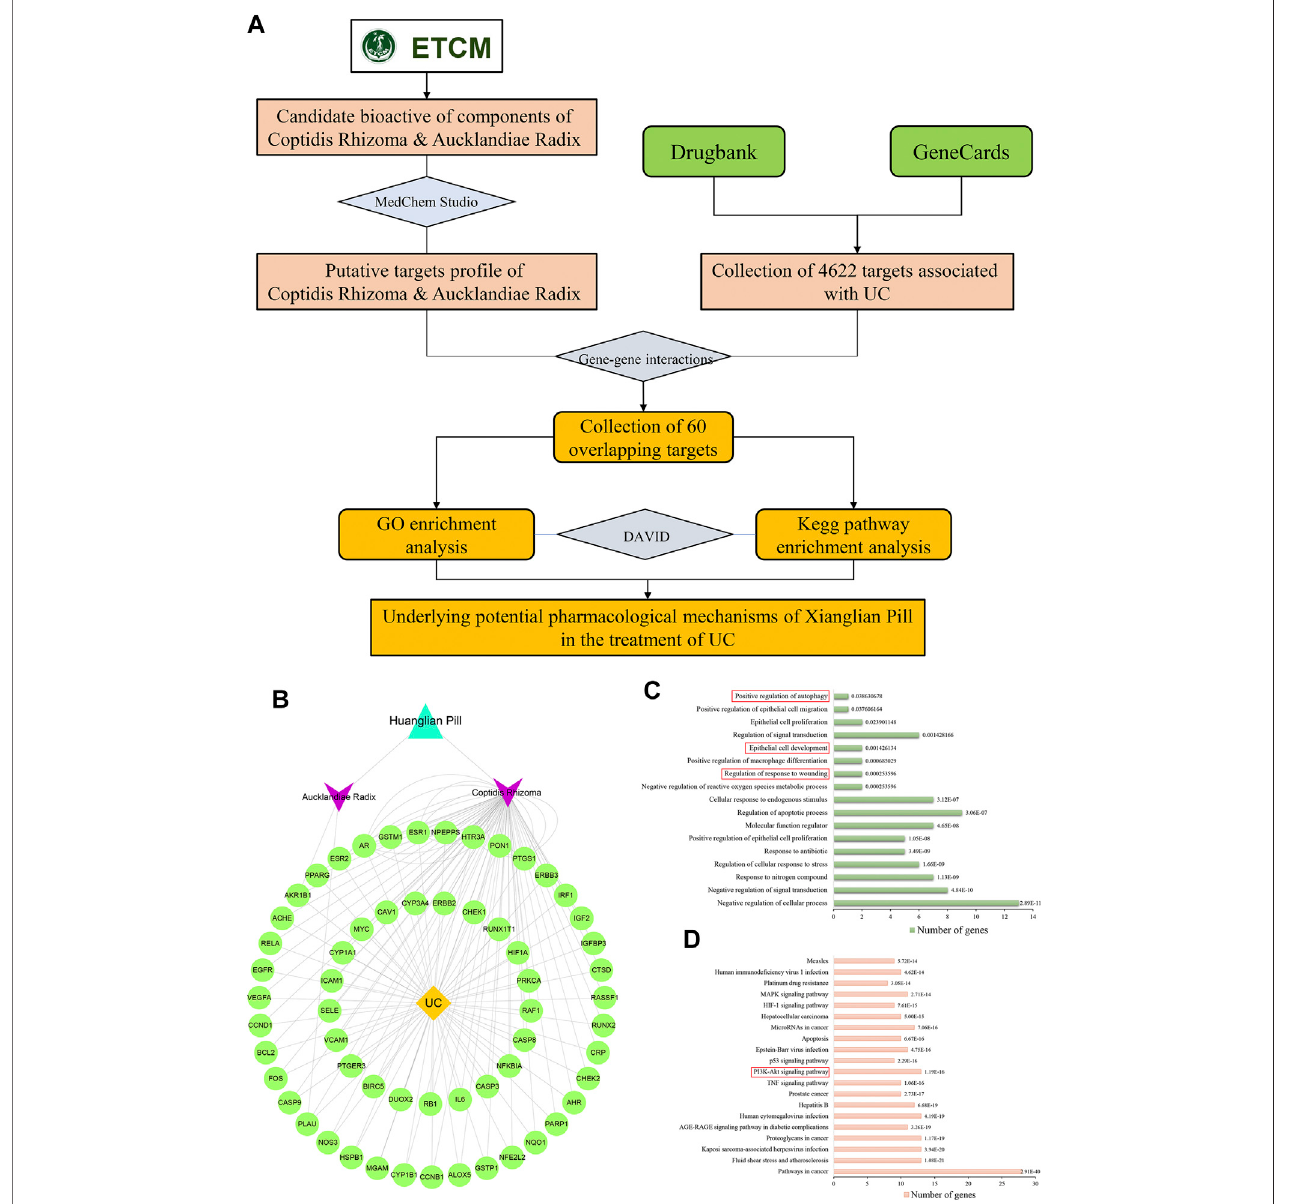
FIGURE 1 | Study of Xianglian pill in the treatment of ulcerative colitis using integrative pharmacology-based approach. (A) The work fl ow of the study using an integrative pharmacology-based approach. (B) Disease gene-drug target network was constructed by Cytoscape software. (C) Results of the analysis of enriched GO biological processes. (D) Results of the analysis of enriched KEGG pathways.